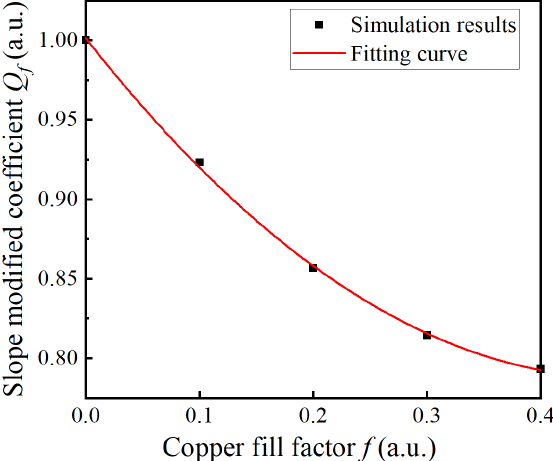
Figure 6. Slope-modified coefficient versus copper fill